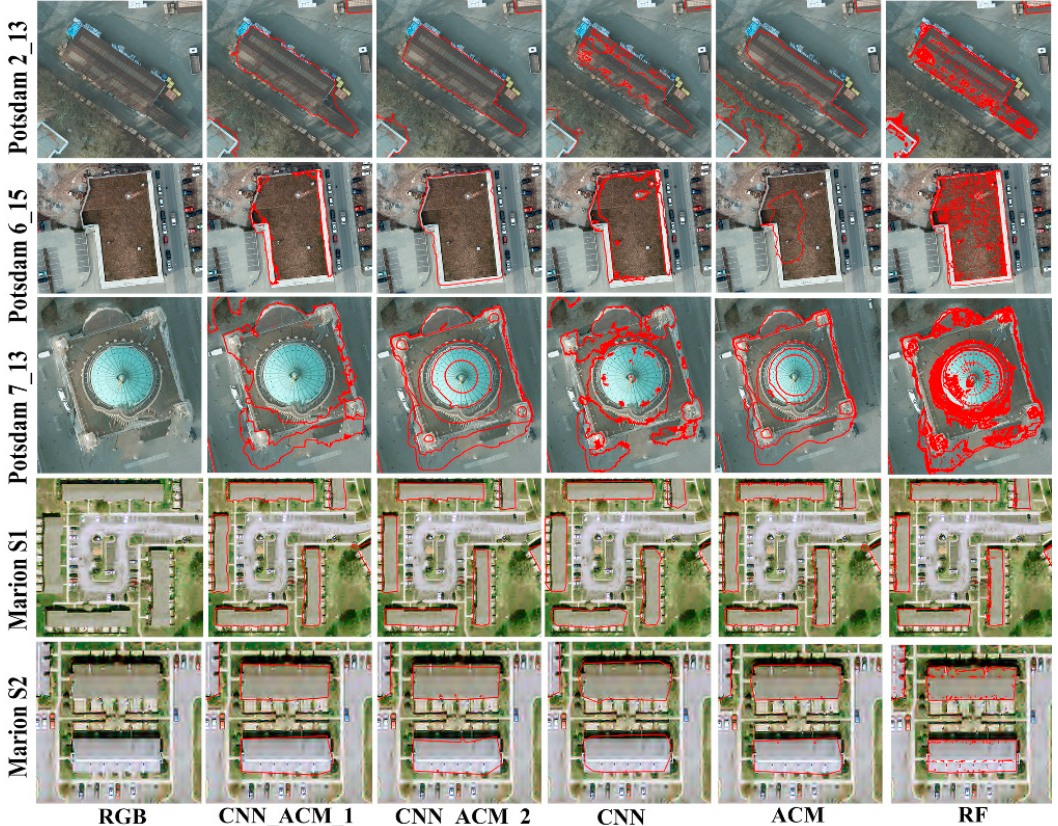
Figure 7. The zoom-ups of the marked buildings in Figure 6 with five different methods.